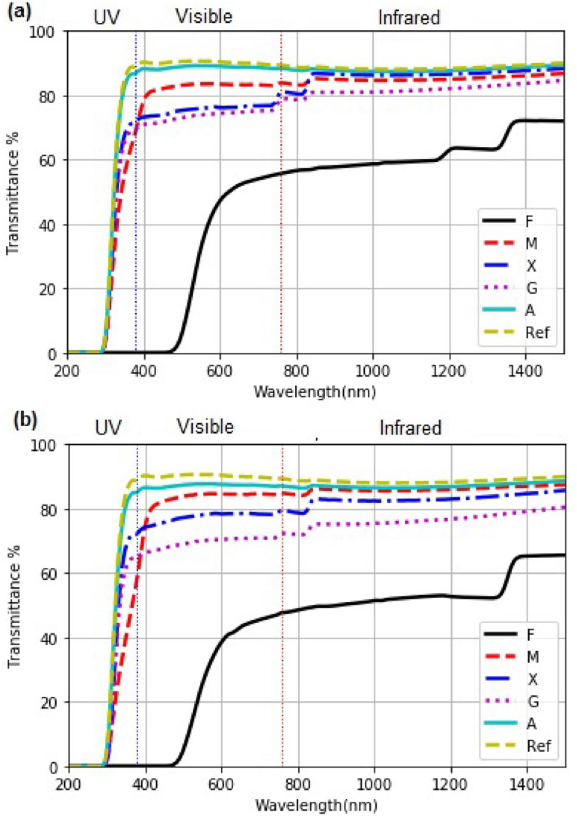
Figure 4. Optical transmittance of the coatings on glass substrates, dry-cast from ( a ) 4 µ L and ( b ) 8 µ L of the solutions.